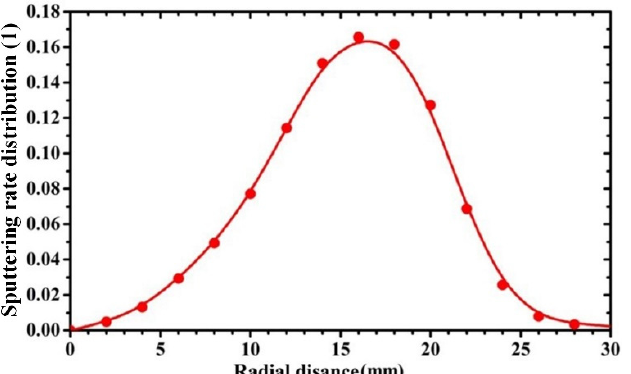
Figure 4. Sputtering rate distribution of the target material along the radial direction of the target